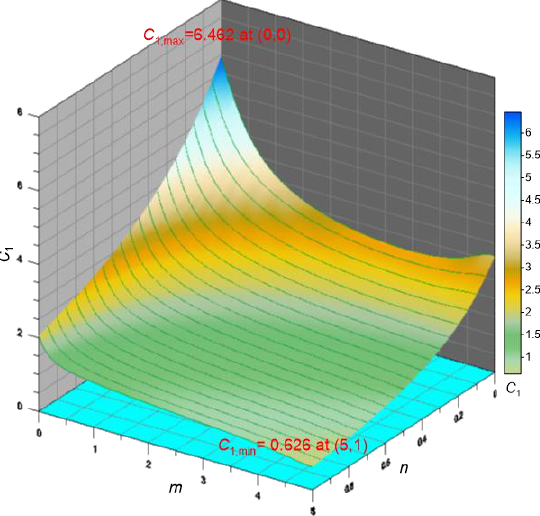
Figure 5. Surface map of (𝑚, 𝑛,𝐶 1 ) for linear taper, 𝑘 = 4 , 𝜆 = 0.03 , and 𝑝 = 0.